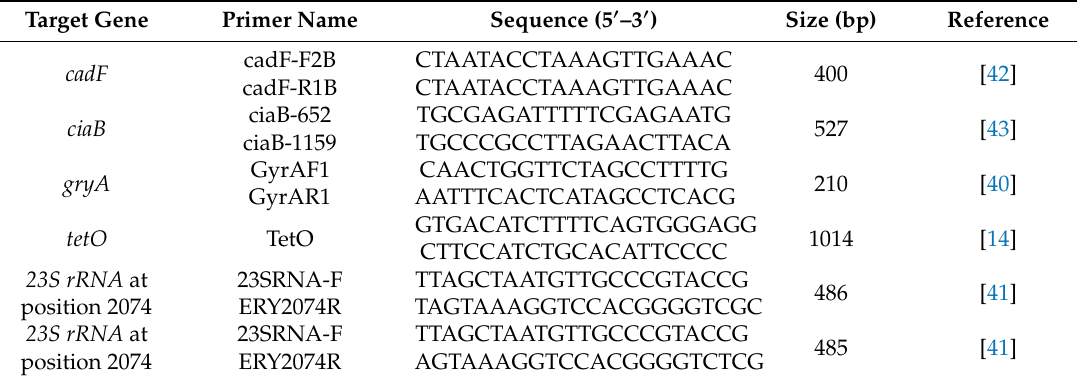
Table 1. Primers used for virulence and resistance genes.